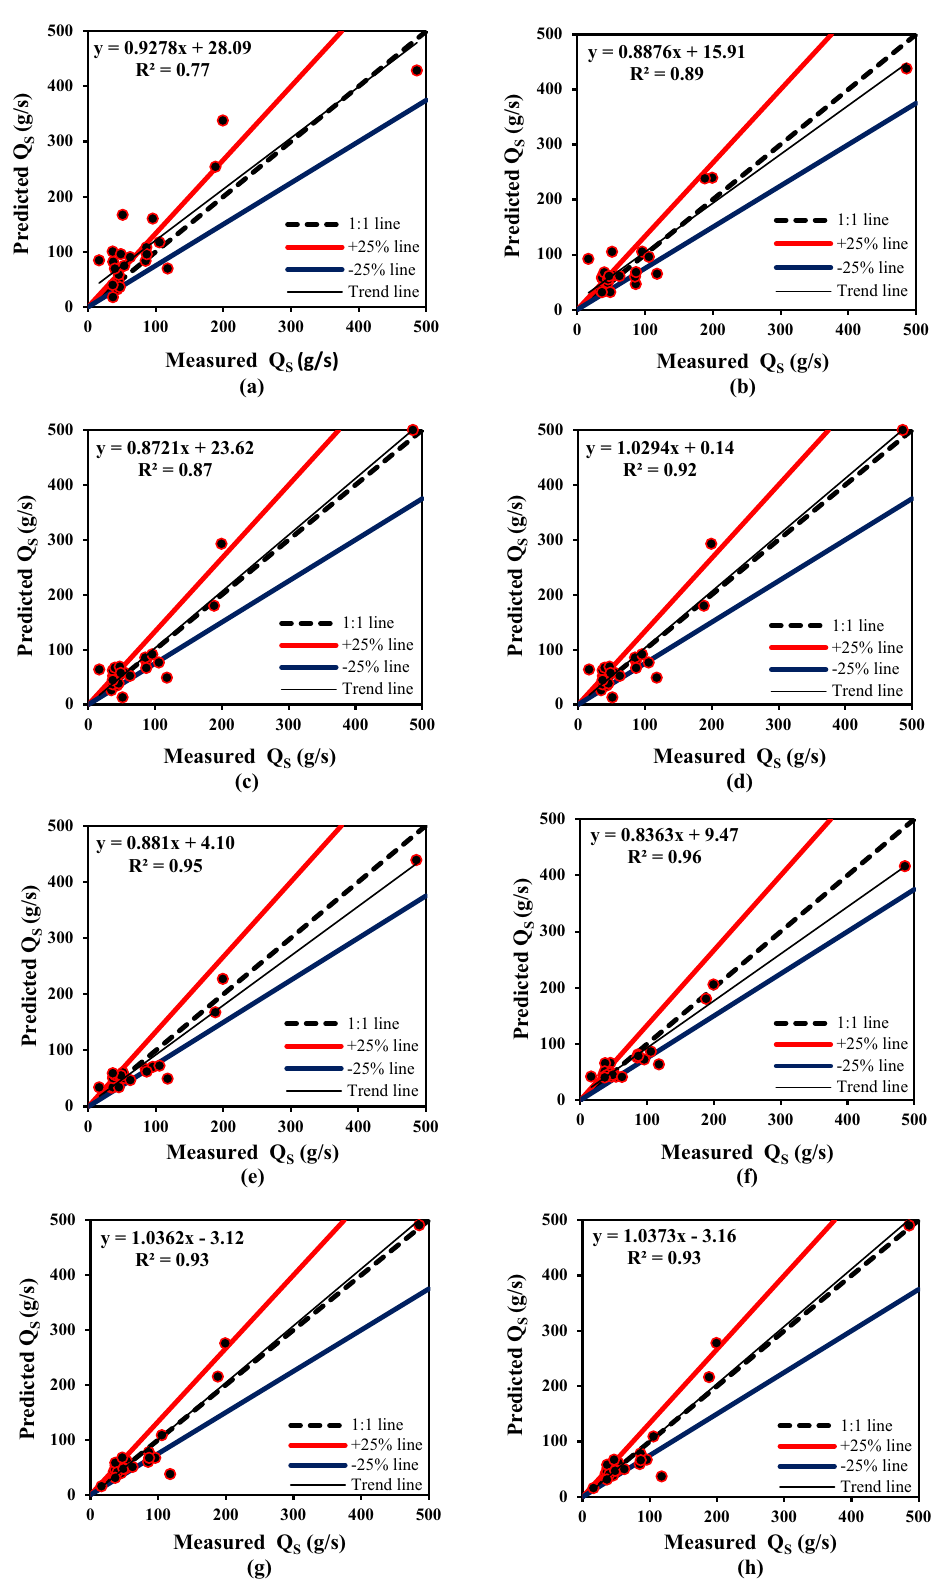
Figure 3. Scatter plots of the measured and predicted Q s in the testing phase. ( a ) MLR; ( b ) ANFIS; ( c ) MLPNN; ( d ) GMDH; ( e ) GMDH-EO; ( f ) GMDH-HGSO; ( g ) SVR-EO; ( h )